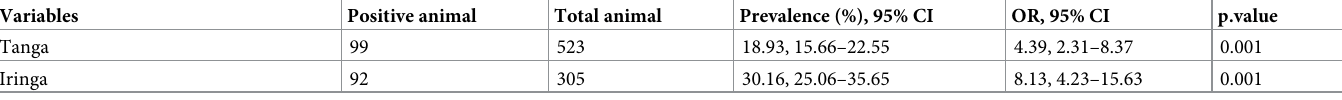
district i , and i = 1, 20, and district, α , is the random intercept, which is assumed to be nor- i mally distributed with mean 0 and variance σ 2 . Model assumptions were not violated as shown in S1 Fig, and the model explained 29.1% of the variation (conditional R 2 ) of which 5.9% was due to random effect. The identified risk factors for antibodies to Leptospira in cattle from the multivariable model (Fig 3) included: age equal to or over 5 years (OR = 1.41, 95%CI 1.05–1.9); Indigenous breed (OR = 2.78, 95%CI 1.47–5.26) compared to other breeds, farmers with livestock training (OR = 1.62 95%CI 1.15–2.27); hiring a bull for breeding (OR = 1.91, 95% CI 1.34–2.71), farm without cats (OR = 1.87, 95% CI 1.16–3.02), animals grazed extensively (OR = 2.31, 95% CI